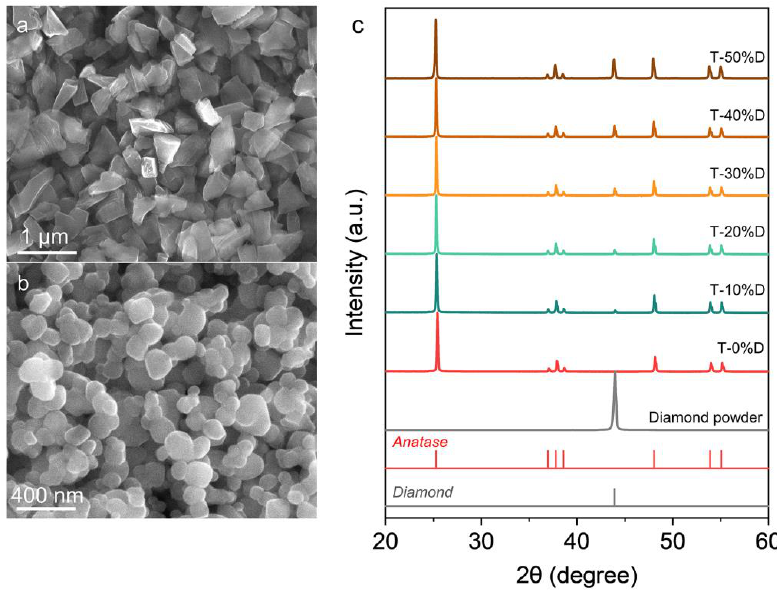
Figure 1. The SEM images of the raw materials: ( a ) diamond, ( b ) anatase-type TiO 2 . ( c ) XRD patterns of the raw materials and powder mixtures. The XRD patterns of synthesized samples are given in Figure 2a. The diffraction peak corresponding to diamond can be seen in the figure, and no diffraction peaks belonging to graphite or titanium carbide were detected. These results indicate that the current syn- thesizing conditions avoids the graphitization of diamond, as well as the reaction between TiO 2 and diamond. In addition, the diffraction peaks belonging to the rutile phase and columbite phase can also be detected, due to the phase transformation of TiO 2 , which is consistent with the previous research results [24]. It is worth noting that there are slight differences in the phase composition of TiO 2 of the samples for different diamond addi- tions. With the increase in diamond additions, the intensity of the diffraction peaks of the columbite phase gradually decreases, and the intensity of diffraction peaks corresponding to the rutile phase gradually increases. An incompletely transformed anatase phase was observed for the composite containing 50 wt.% diamond. Furthermore, the quantitative results of phase composition obtained by Rietveld refinement are shown in Figure 2b. With the increase in diamond additions, the content of the columbite phase rapidly de- creases from nearly 87.3 wt.% in the T-0%D sample to 21.3 wt.% in the T-50%D sample. The content of the rutile phase in the composites increases with diamond content and reaches 23.7 wt.% when the diamond content is 50 wt.%. These results indicate, on the one hand, diamond hinders the phase transformation from anatase to columbite, and on the other hand, promotes the phase transformation from anatase to rutile. As the diamond content increases, the effect of hindering phase transformation becomes more pronounced; thus, when the content of diamond in the composite is 50 wt.%, the remaining anatase phase reaches 5.1 wt.%.